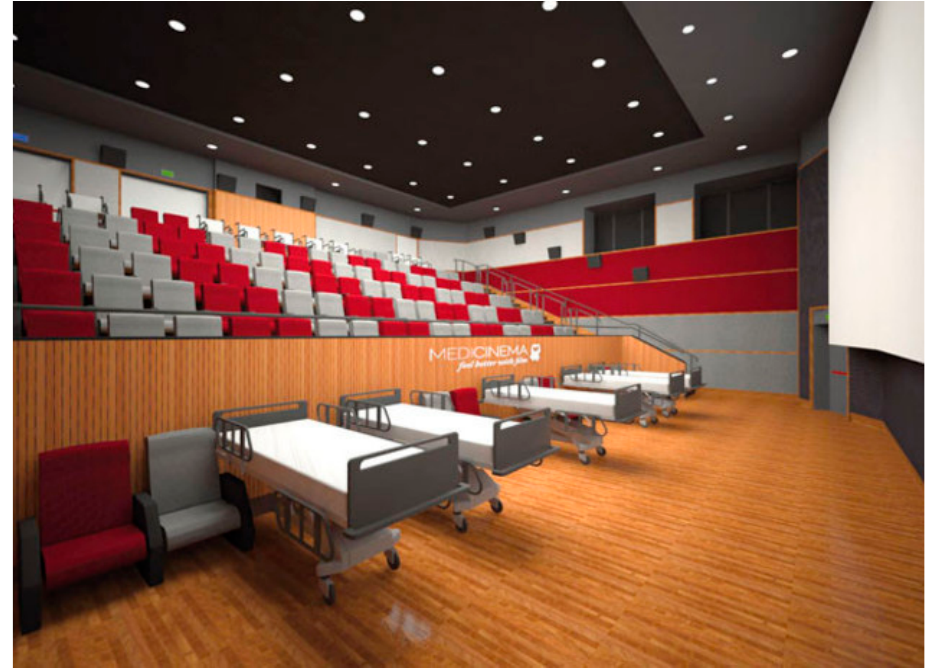
Figure A1. Medicinema Hall at Policlinico Agostino Gemelli, Rome.